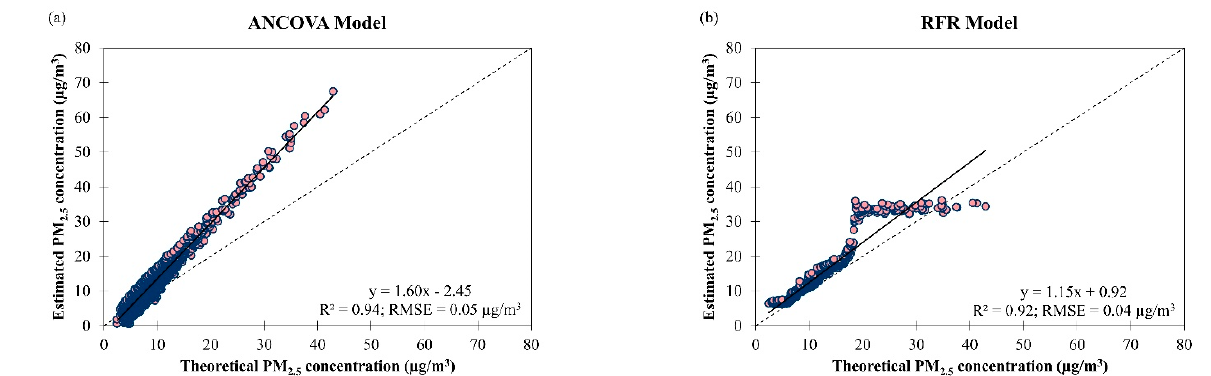
Figure 13. Scatter plots of estimated daily PM 2.5 concentration against theoretical daily PM 2.5 concentration by ( a ) ANCOVA and ( b ) RFR models for overall air quality in Brunei Darussalam from January 2009 to December 2019.